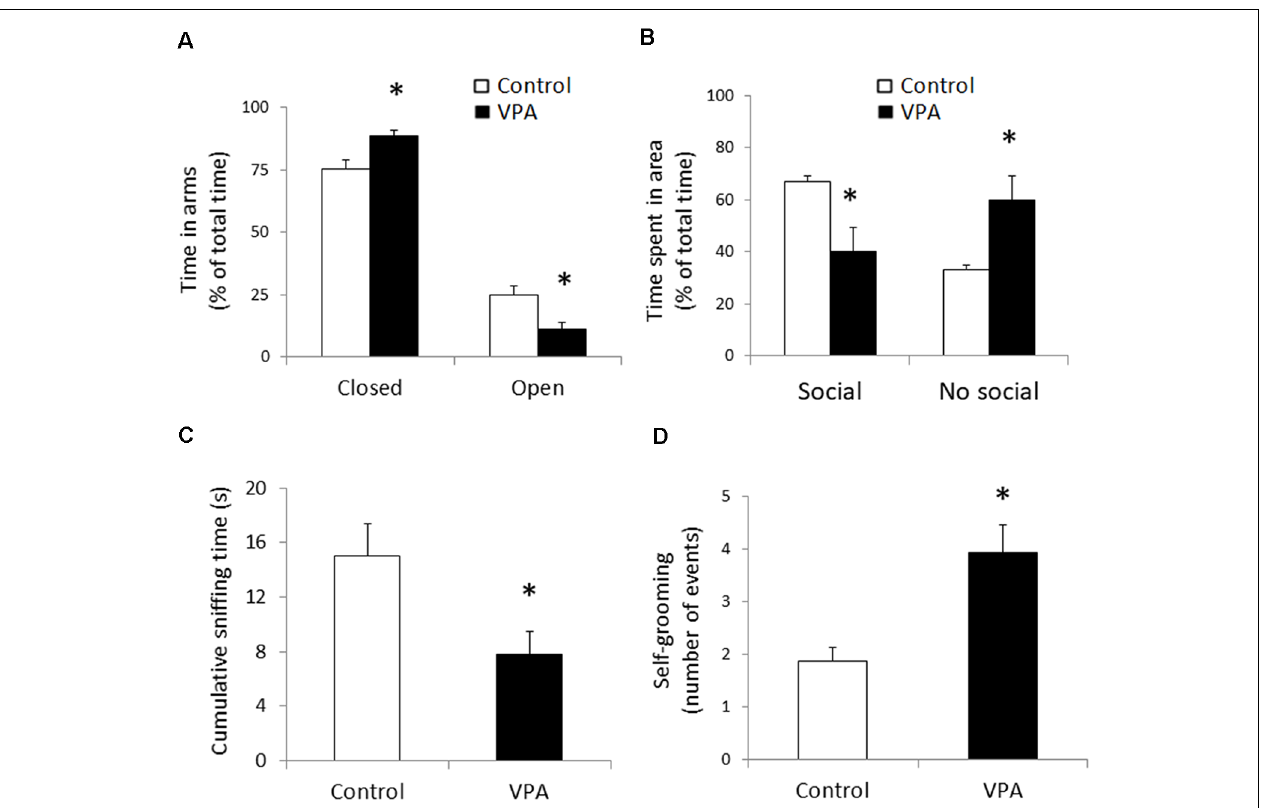
FIGURE 1 | Prenatal Valproate treatment produces autism-like behavior. Percentage of the total time spent in closed and open arms in the elevated plus maze (A) . Percentage of the total time spent in social and non-social areas in the three-chamber social test (B) . Cumulative sniffing time in social chamber of the three-chamber social test (C) . Number of self-grooming events during the social test (D) . The data represent the mean ± standard error of the mean (SEM) and controls are represented by white bars, while VPA-treated animals are represented by black bars. ∗ p < 0.05 t -test ( n = 10) for elevated plus maze and ∗ p < 0.05 U -test ( n = 8) for all parameters from the social